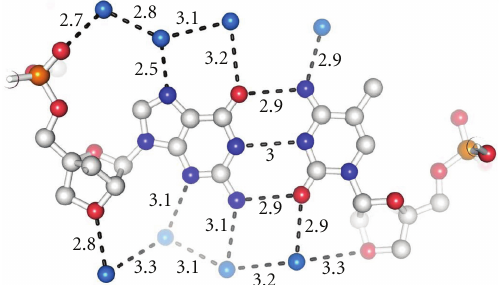
Figure 3: Hydration pattern within the LNA duplex (PDB ID: 2X2): a region of the LNA helix showing the base pair (G4-m 5 C69) L . The hydration pattern resembles that known for RNA, as the bridged 2 (cid:2) - oxygen atom in LNA acts as a hydrogen bond acceptor similar to the 2 (cid:2) -oxygen in the hydroxyl group of